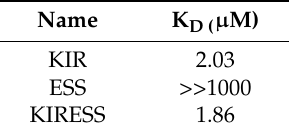
Table 2. Dissociation constants values (K D ) of SOCS3 derived peptides toward Janus kinase (JAK2) catalytic domain obtained by surface plasmon resonance (SPR) experiments. KIR—kinase- inhibitory region.